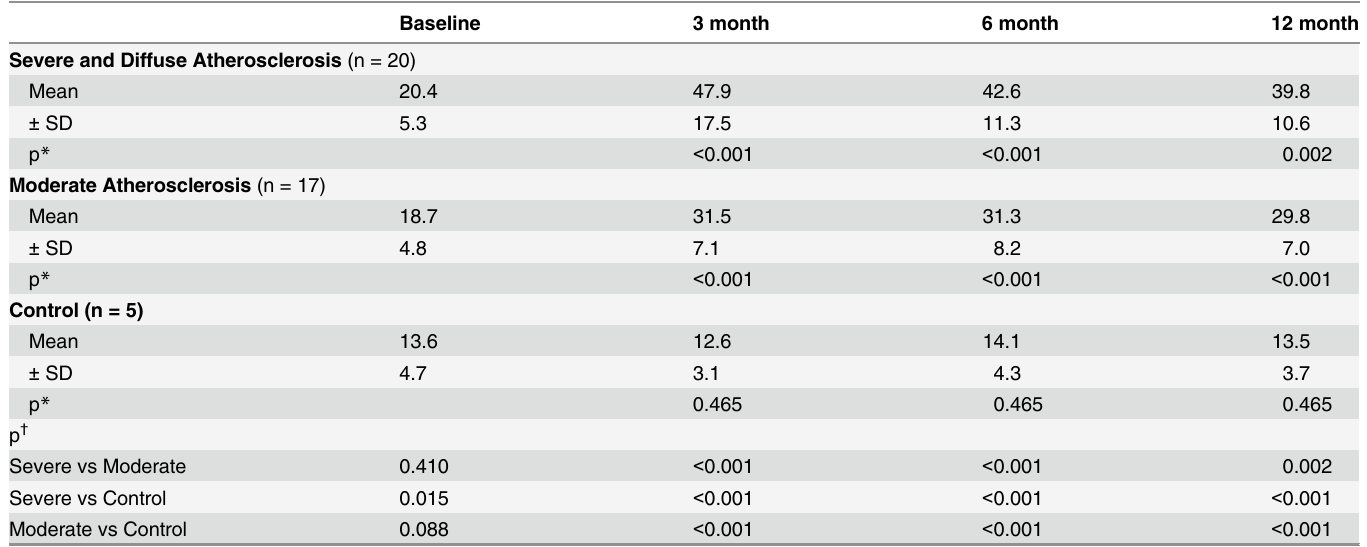
Table 8. Fasting oxLDL Levels (units/L).